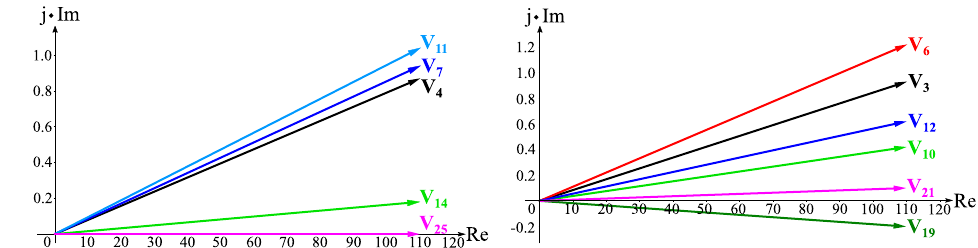
Fig. 11. – Voltage phasors of storage power plants (left) and that of PV generators (right), after the initial